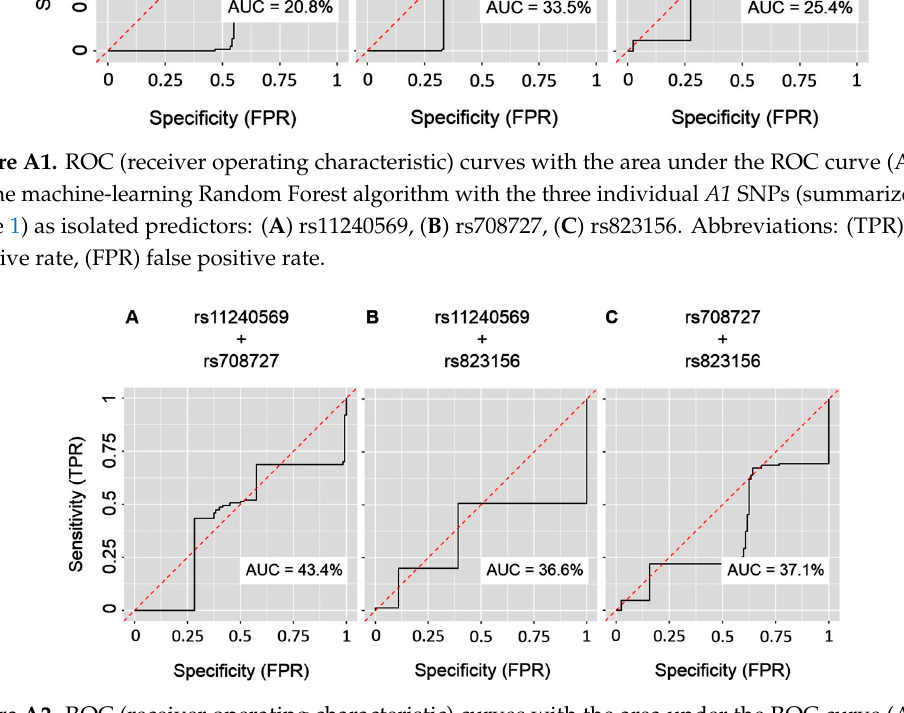
Figure A2. ROC (receiver operating characteristic) curves with the area under the ROC curve (AUC) for the machine-learning Random Forest algorithm with the nine genotypic duplets (summarized in Table A2) of the paired A1 SNPs as predictors: ( A ) rs11240569 + rs708727, ( B ) rs11240569 + rs823156,